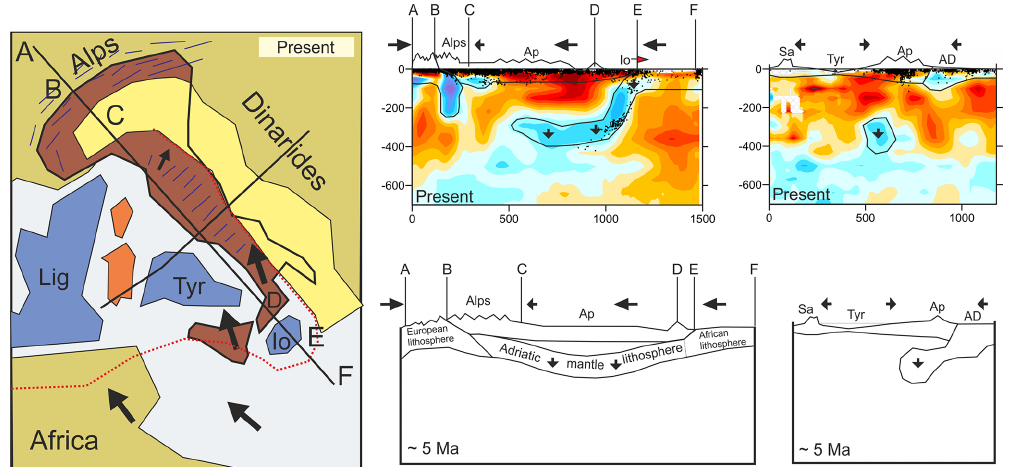
Figure 9. Schematic representation of the origin of the Calabrian sausage background in plots with sections of present configuration cor- responds to P velocity anomalies in vertical sections 1 and 2. Black arrows schematically indicate the displacements of blocks; red arrow denotes the direction of the Calabrian trench retreat. Abbreviations: Ap – Apennines; Io – Ionian Sea; Tyr – Tyrrhenian Sea; AD – Adriatic Sea; Sa – Sardinia; Lig – Ligurian